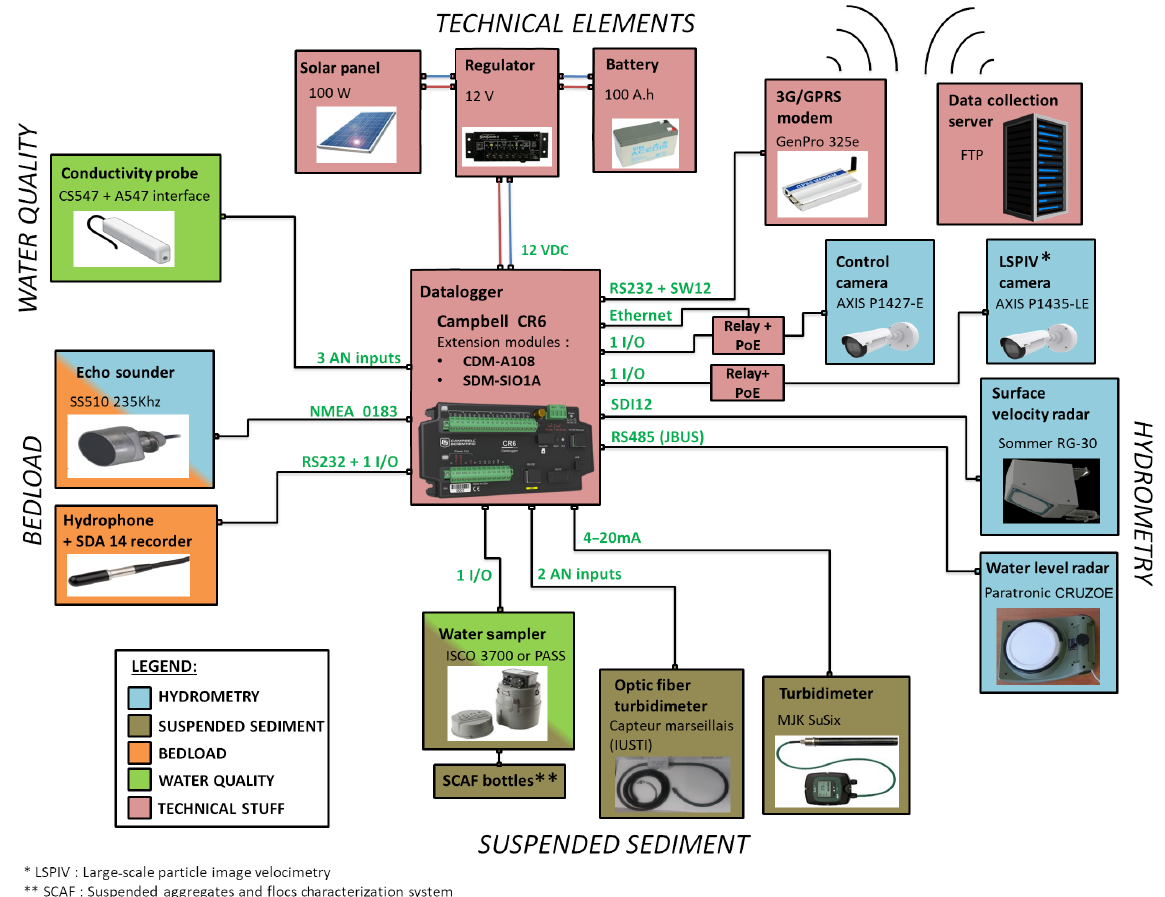
Figure 2. The RIPLE platform